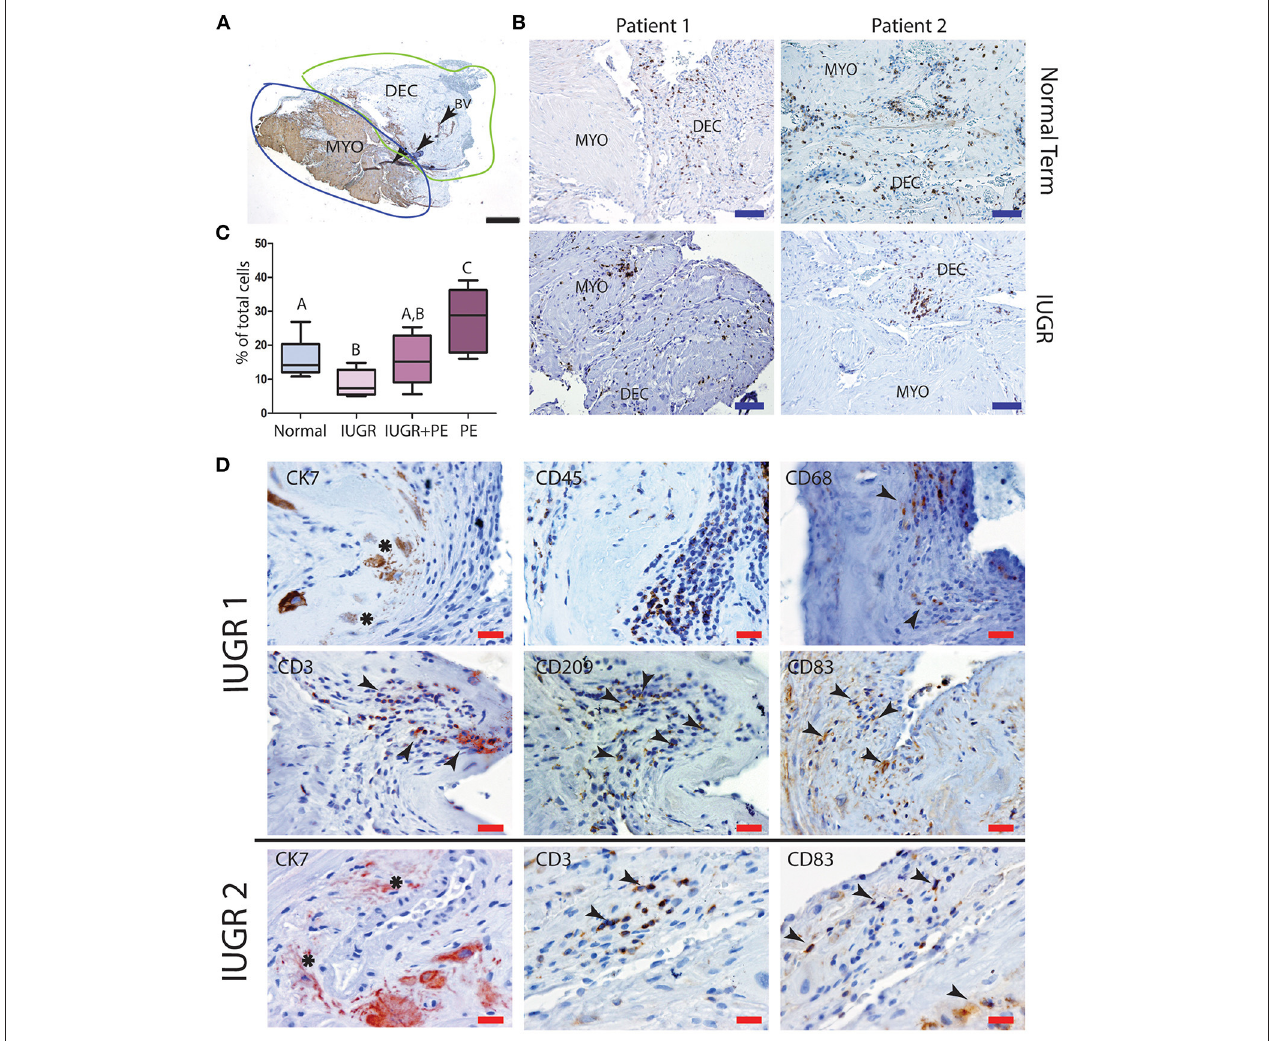
FIGURE 4 | Low decidual leukocyte number and increased mature dendritic cells in association with apoptotic EVT in IUGR. Visiopharm Newcast image analysis system was used to define decidual and myometrial regions based on smooth muscle actin staining of the myometrium (A) . Representative stained decidual and myometrial sections from normal term PBBx upper panel and IUGR PBBx lower panel (B) . Numbers of brown stained CD45 + leukocytes and blue hematoxylin stained decidual stromal cells or myometrial muscle cells were counted in corresponding serial sections across 5% of the respective region using Visiopharm Newcast image analysis system and random meander sampling (C) : Normal n = 15, IUGR n = 8, IUGR and PE n = 5, PE n = 8) ( A,B p < 0.01, A − C p < 0.0001, B,C p < 0.001). Representative serial sections of IUGR PBBx show that the apoptotic mural EVT (CK7, asterisks) that were observed in these biopsies were associated with leukocyte clusters (CD45) containing CD68 + macrophage and elevated number of CD3T cells and CD83 + mature dendritic cells ( D , arrows). Scale bars: black = 500 µ M, 20x magnification, blue = 250 µ M, 40x magnification, red = 20 µ M,